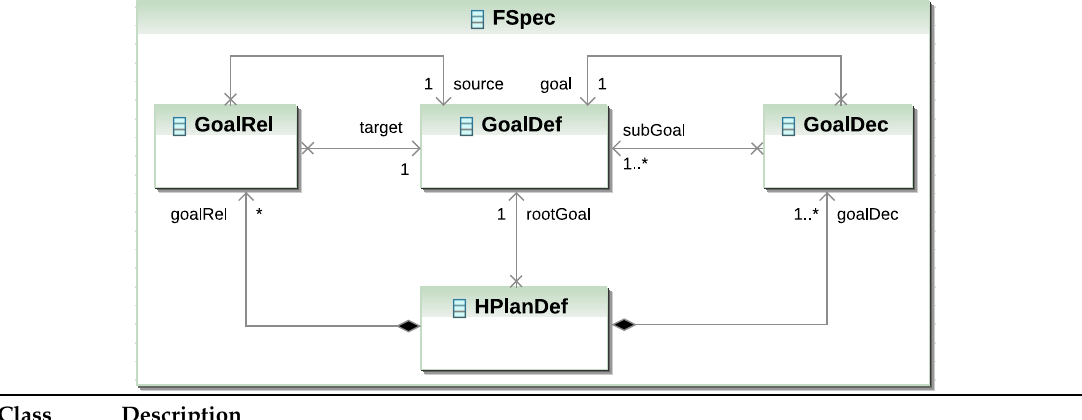
Table 2. Functional specification pattern: Classes